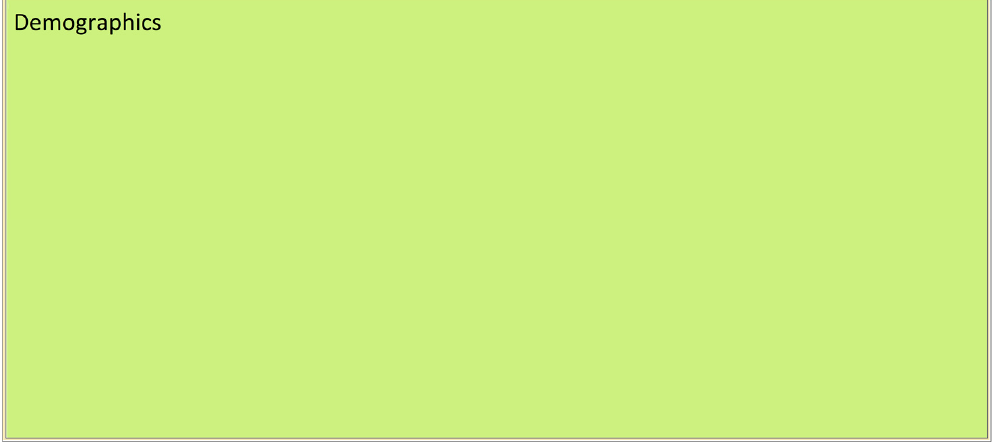
Figure 12. Hierarchy chart of miscellaneous factors.